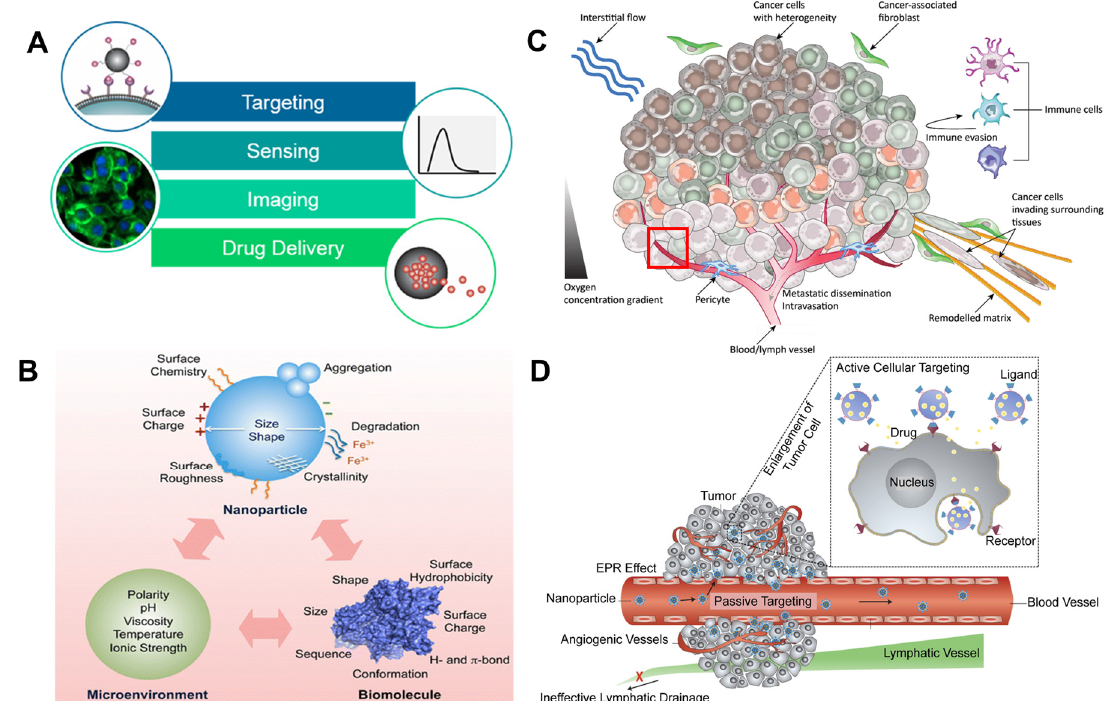
Figure 1. (A) Interface in cancer microenvironment: “magnified views” are schematic illustrations of Figure 1. ( A ) Interface in cancer microenvironment: “magnified views” are schematic